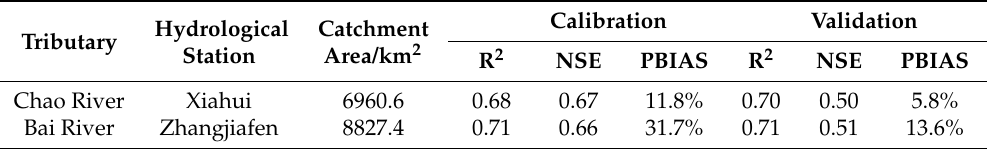
Figure 2. Monthly observed and simulated discharge at Xiahui station along Chao River. Table 2. The results of statistical evaluation indices during calibration and validation at Xiahui station along Chao River and Zhangjiafen station along Bai River.